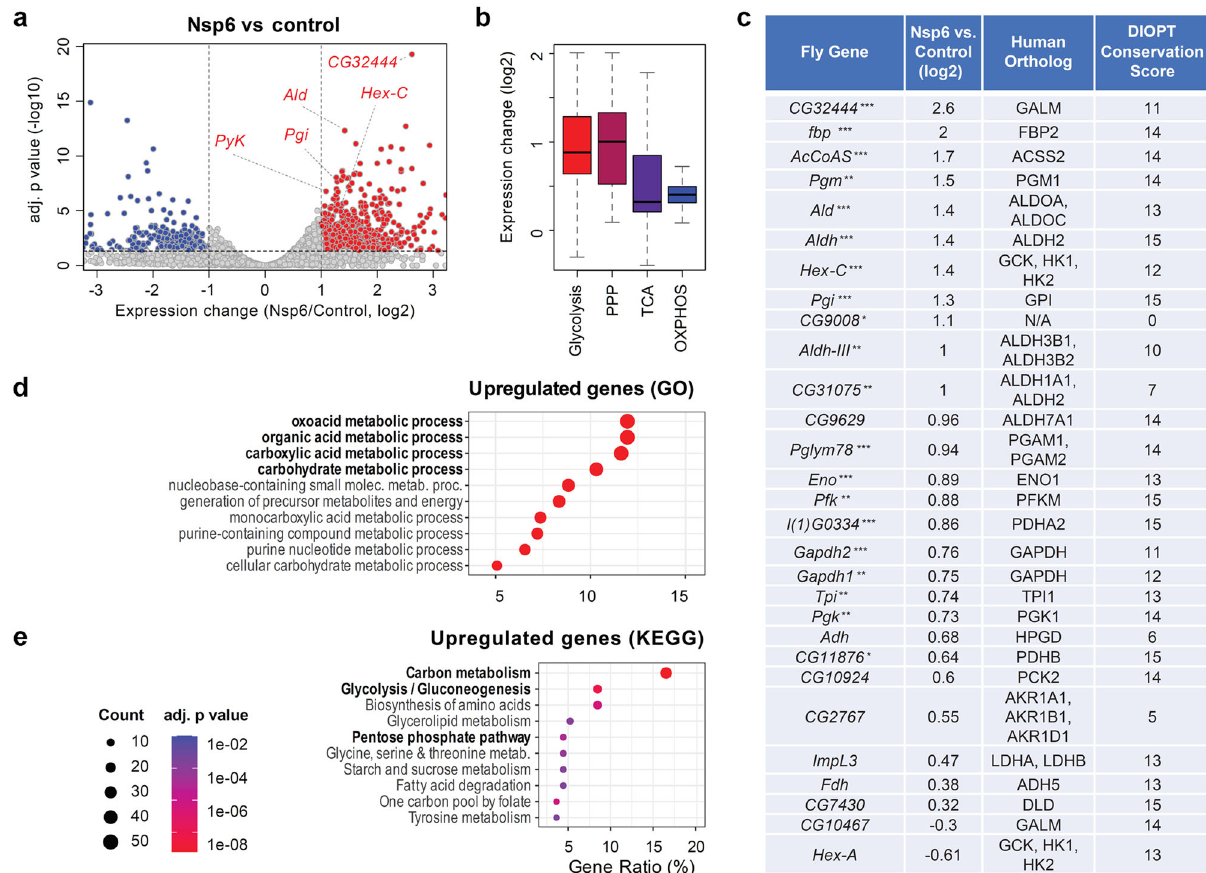
Fig. 2 SARS-CoV-2 Nsp6 alters the expression of host glycolysis genes in the fl y heart. a Differential expression of fl y heart genes upon 4X Hand -Gal4 cardioblast-speci fi c transgenic overexpression (OE) of UAS- SARS-CoV-2 Nsp6 . X-axis: Gene expression differences between the Nsp6 -expressing heart versus wild-type control ( w 1118 ) in log2 scale. Y-axis: Adjusted P values in − log10 scale. Each dot represents a gene: Red color denotes genes upregulated in Nsp6 -OE fl y hearts; Blue color denotes genes downregulated in Nsp6 -OE fl y hearts. b Box plot summarizes differentially expressed genes in SARS-CoV-2 Nsp6 -OE fl y heart compared to wild-type control ( w 1118 ) heart, involved in Glycolysis, Pentose Phosphate Pathway (PPP), TriCarboxylic Acid cycle (TCA) and OXidative PHOSphorylation (OXPHOS). The top and bottom of each box corresponds to the upper and lower quartiles, respectively. Each thick line represents the median value. Whiskers indicate the largest, or smallest, observations within 1.5 times of the interquartile range (upper-lower) from the top/ bottom of the boxes, respectively. c Gene expression changes of fl y glycolysis genes with their human orthologs. Orthology information and conservation scores were obtained from DIOPT (max conservation score = 15). * adjusted P < 0.05, ** adjusted P < 0.01, *** adjusted P < 0.001. Enrichment of genes with speci fi c Gene Ontology (GO) terms ( d ) or KEGG-de fi ned pathways ( e ). Circle size: Number of genes associated with the function. Color: Adjusted P values. X-axis represents the percentage of genes with the function among all the signi fi cantly upregulated (adj. P value < 0.05)